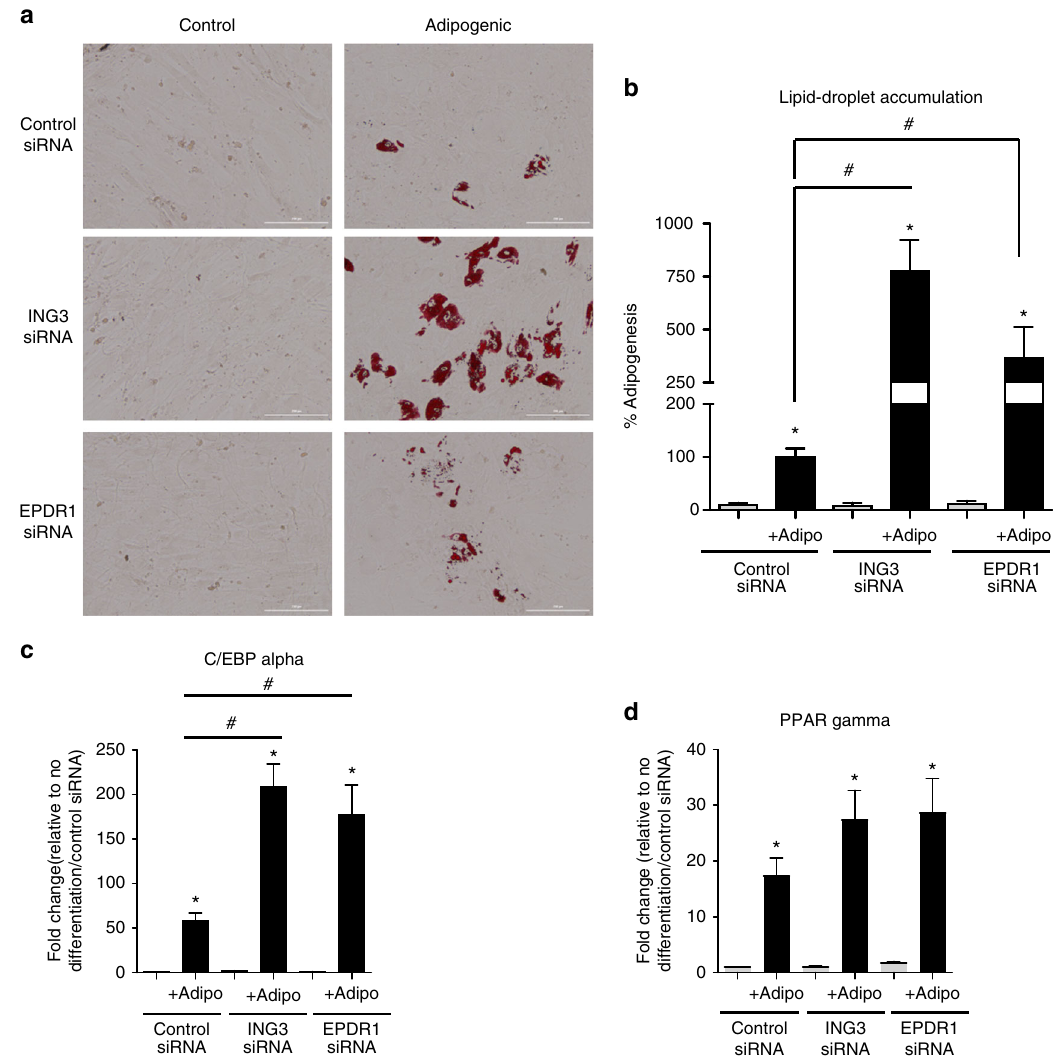
Fig. 3 ING3 and EPDR1 knockdown increases adipogenic differentiation of hMSCs. a ING3 and EPDR1 siRNA transfected cells were stimulated with adipogenic differentiation medium for 21 days and stained with Oil Red O for visualization of lipid droplets. Representative results of two hMSC donor lines are shown (scale bar = 200 μ m). b Relative number of lipid droplets (>25 nm diameter) from 100 different microscopic fi elds were enumerated from three different experiments (two donor lines) and presented as % adipogenesis compared to control samples. c , d Quantitative gene expression. Gray columns = No differentiation; Black columns = Adipogenic differentiation for 1 week (Adipo). Columns = mean. Error bars = standard deviation. n = 3 unique donor lines. * p < 0.05 comparing no treatment to adipogenic differentiation for each siRNA. # p < 0.05 comparing control siRNA to siRNA for gene of interest (two-way homoscedastic Student ’ s t -tests). Source data are provided as a Source Data fi